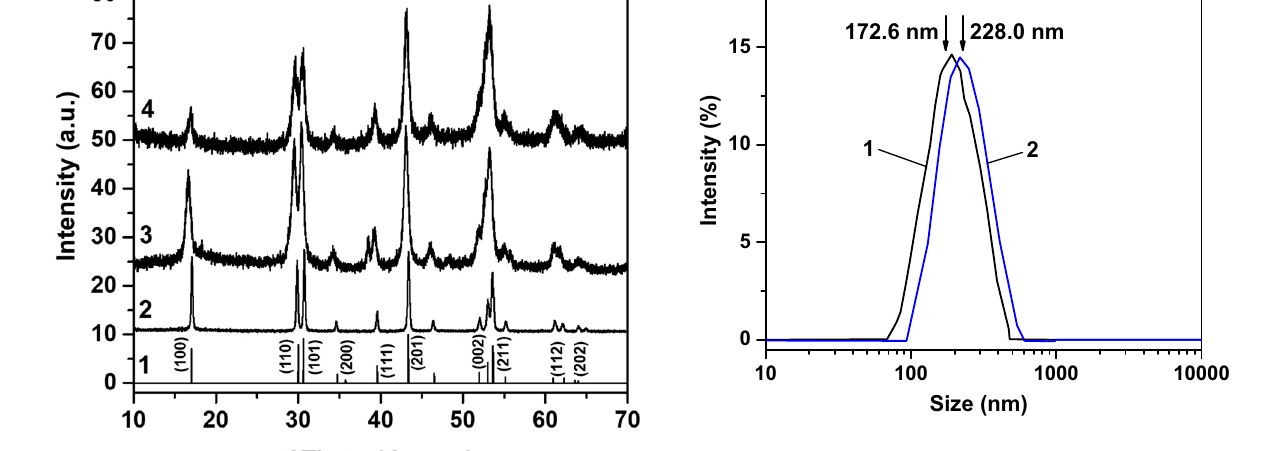
Figure 6: Size distributions by the intensity of the colloids of ball - milled NPs of NaY F : Yb Figure 5: XRD spectra. Plot 1 ( JCPDS card No. 28 - 1192 ) of the NaYF 4 measurement. Distribution 1 corresponds to the NPs made from the β - phase ( hexagonal ) . 2 – NaYF β - phase ( hexagonal ) freshly made large - fl ake powder; 2 – the NPs made from small - fl ake powder. 4 powder baked at 500°C for 1 h; 3 – the same ball milled powder, Vertical arrows down mark the average size of the NPs ( assuming fi ltered through 1 µm fi lter, oleic acid added; 4 - the same ball milled their spherical shape ) on the size scale: 172.6 nm for distribution 1 powder, fi ltered through 1 µm fi lter, no oleic and 228.0 nm for distribution 2.